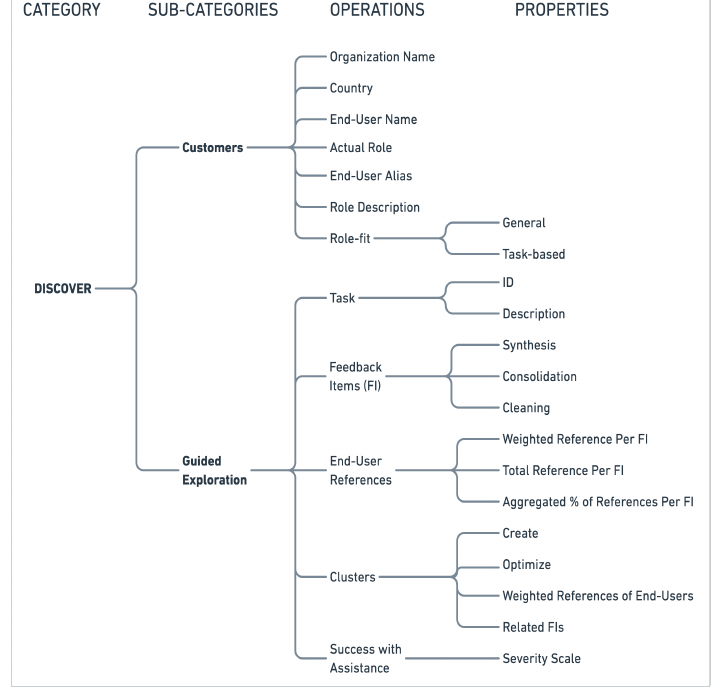
Figure 2. The discover category, sub-categories, operations, and